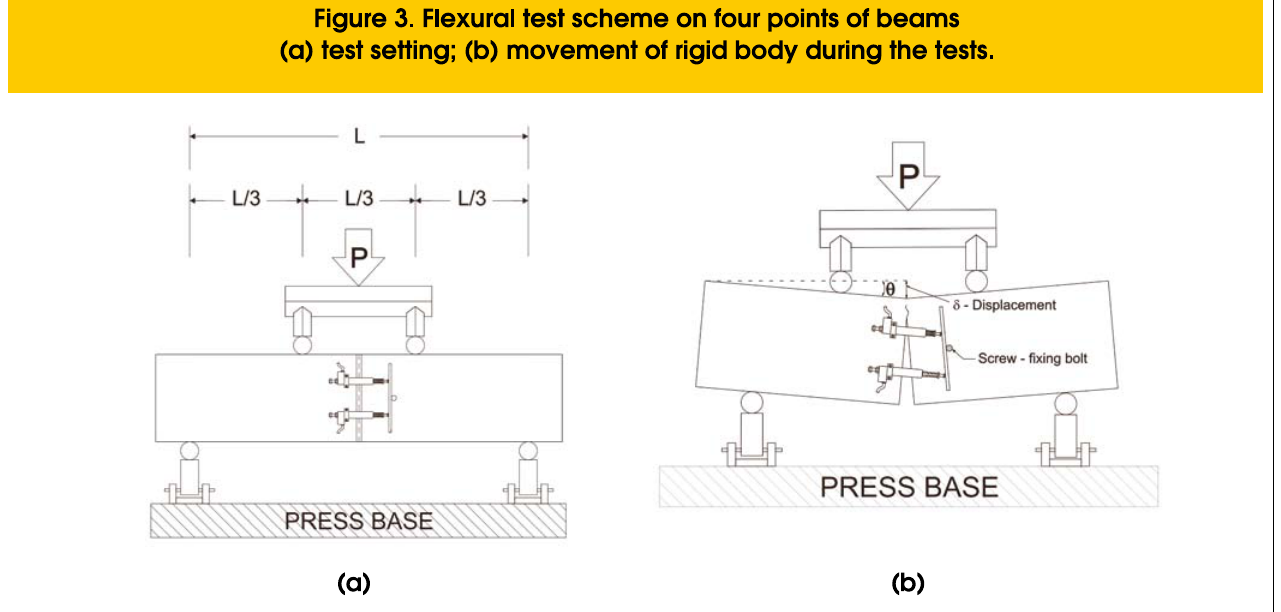
In Figure 4 it is presented a displacement transducers rotation scheme by reason of the beam